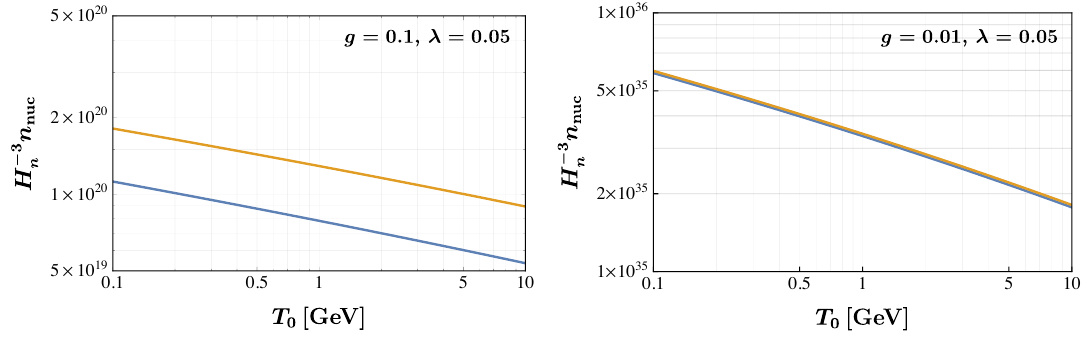
Figure 8 . The number of nucleation sites in a Hubble patch at the bubble nucleation temperature T n for the potential in (C.5). The blue line includes only the a term in the expansion (C.4) as in (C.7), while the orange curve includes both the a and b terms in the expansion. We have chosen D = g 2 and E = g 3 as argued at the end of appendix C, and the two panels are plotted with g = 0 . 1 and 0.01 respectively. Here we approximately have T n ≈ T 0 for the parameters